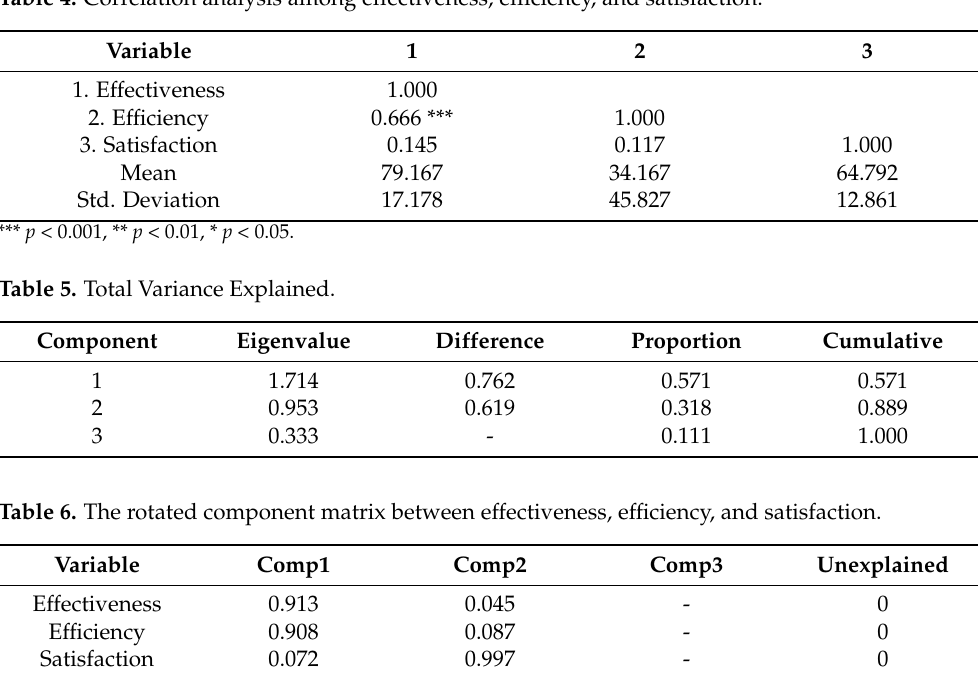
Table 4. Correlation analysis among effectiveness, efficiency, and satisfaction.